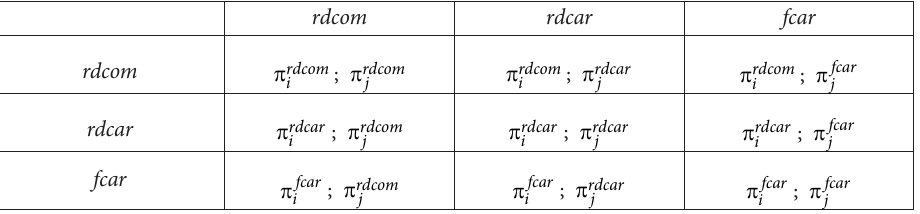
Table 3. Profit-based decision table for R&D strategies